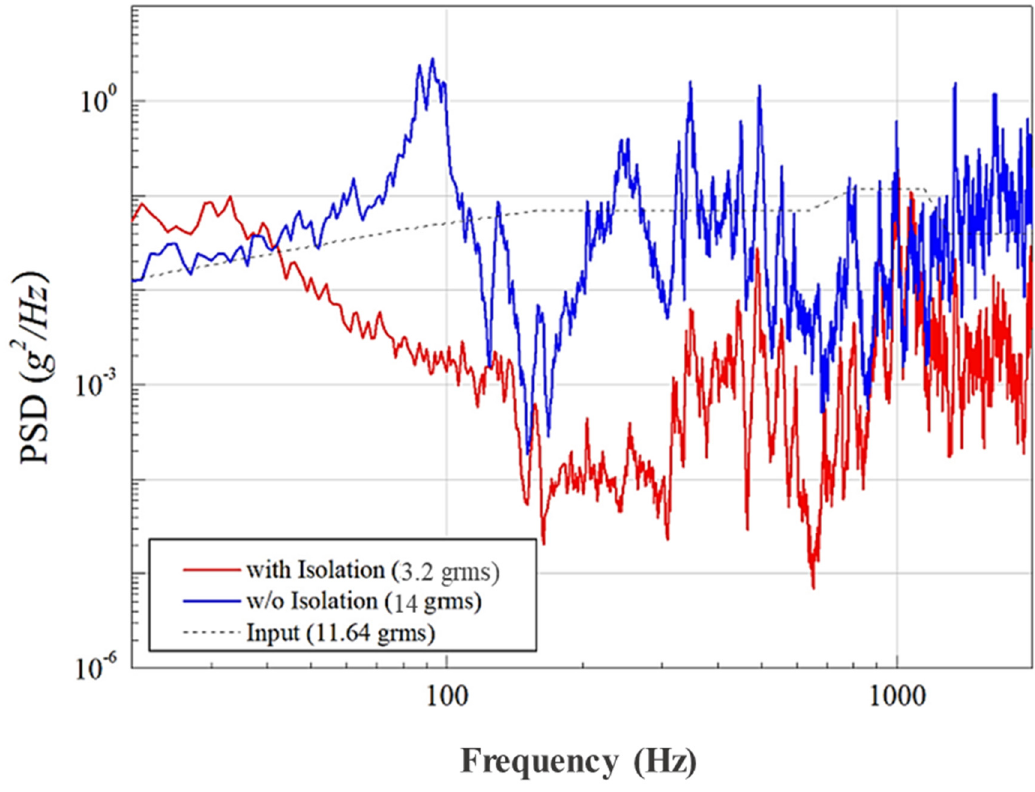
Figure 20. Random vibration test result of the dummy S-STEP’s CoG under qualification level random vibration specifi- cation.